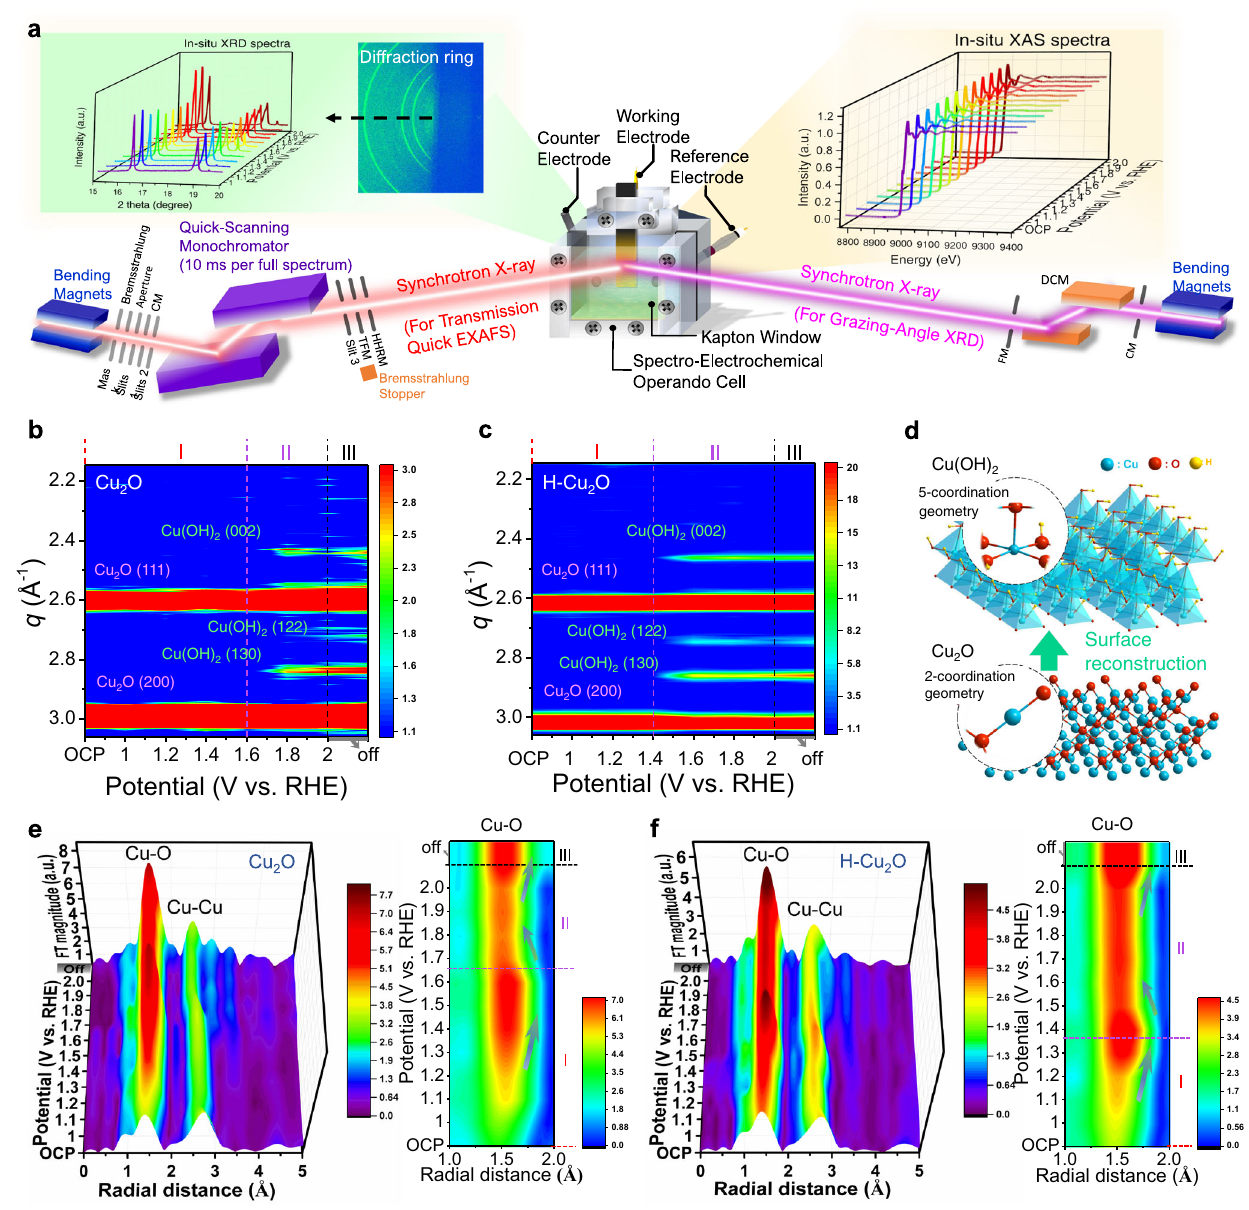
Fig. 2 | Operando GAXS and quick-XAS characterizations for the OER. a Schematic illustration of the operando liquid electrochemical cell for the GAXS and quick-XAS apparatus. Operando GAXS of ( b ) pure Cu 2 O and ( c ) H-Cu 2 O cata- lysts. d Proposed structural reconstruction during OER. Operando Fourier-